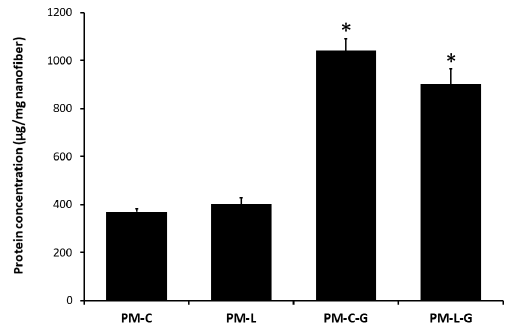
Figure 1. Collagen (C) and laminin (L) adsorption on the poly(methyl methacrylate) (PMMA) nanofiber (PM) scaffold, with and without genipin (G). All groups have been normalized to the PM scaffolds. * Indicates a significant difference for collagen-coated PM scaffolds with genipin (PM-C-G) and laminin-coated PM scaffolds with genipin (PM-L-G) vs. the respective control coating.